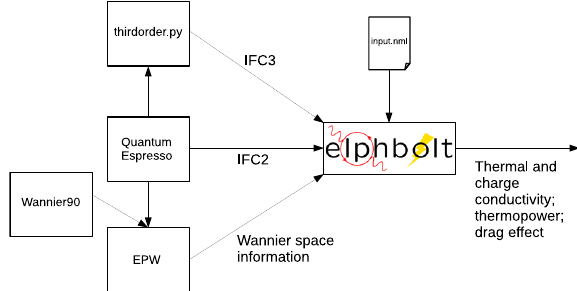
Fig. 1 Work fl ow of elphbolt showing the various input data required for a coupled e – ph BTEs calculation. Data generated by the external codes shown in the boxes on the left are passed into elphbolt, which carries out the transport calculations to generate the results listed on the